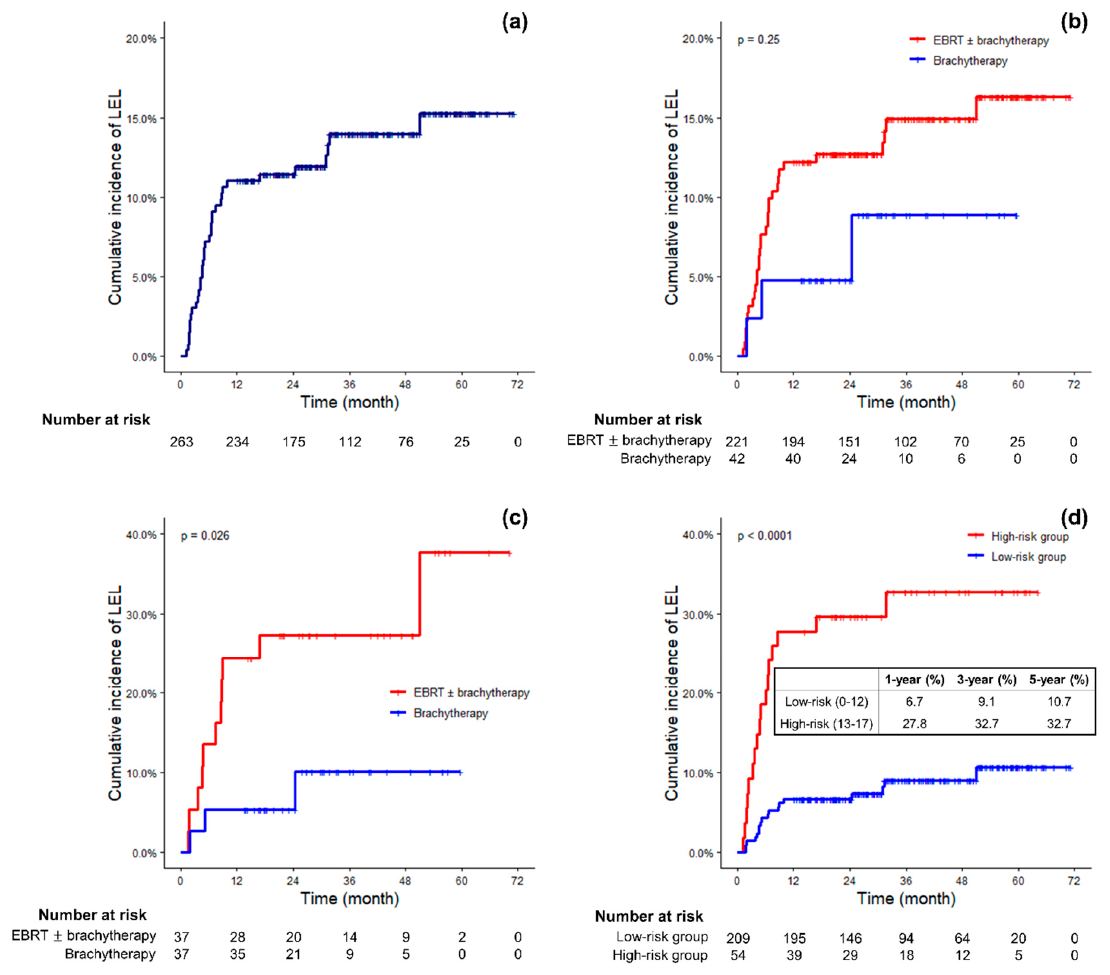
Figure 1. ( a ) Cumulative incidence of lower extremity lymphedema (LEL) in general. ( b , c ) Cumulative incidence of LEL according to radiation therapy modality in the entire cohort and in the matched cohort. ( d ) Cumulative incidence of LEL according to risk groups .